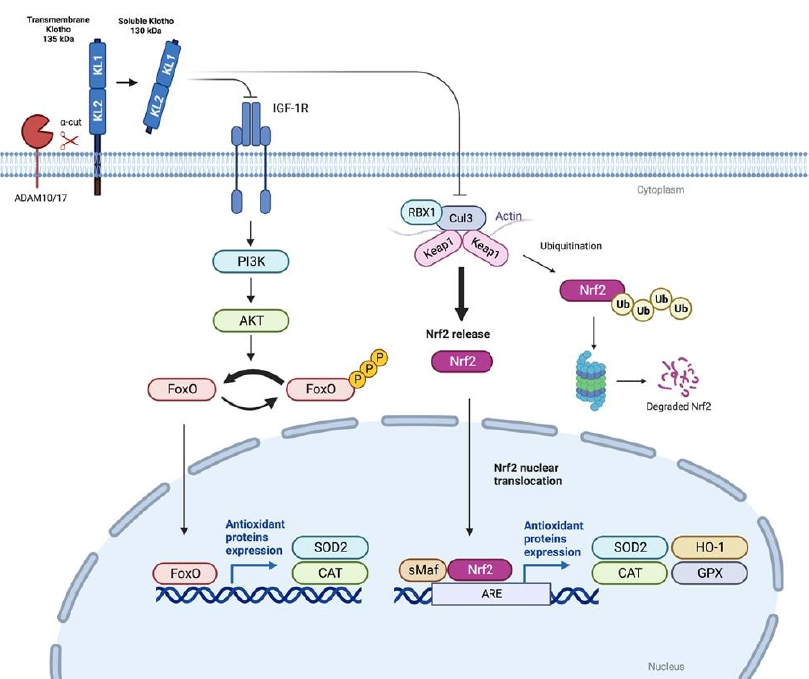
Figure 2. Soluble Klotho-mediated antioxidant mechanisms. Membrane Klotho can be cleaved by membrane-anchored secretases ADAM10/17, which release the extracellular domain into the extracellular space. Soluble Klotho decreases oxidative stress via the inhibition of insulin/IGF- 1/PI3K/Akt/FoxO pathway, promoting the expression of superoxide dismutase (SOD2) and catalase (CAT). Similarly, soluble Klotho also reduces oxidative stress through the activation of the cellular protective Nrf2 pathway, which promotes the transcription of genes related to antioxidant defense, such as hemeoxygenase-1 (HO-1), SOD2, CAT, and glutathione peroxidase (GPX), among others.